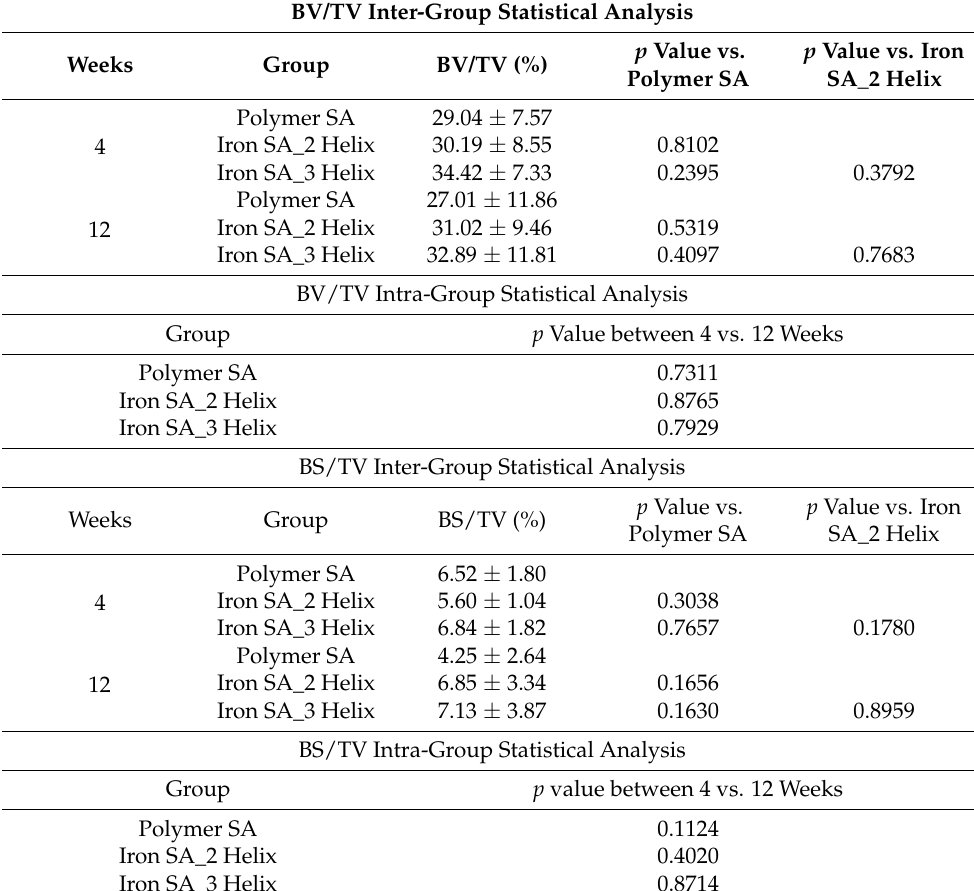
Table 4. Micro-CT